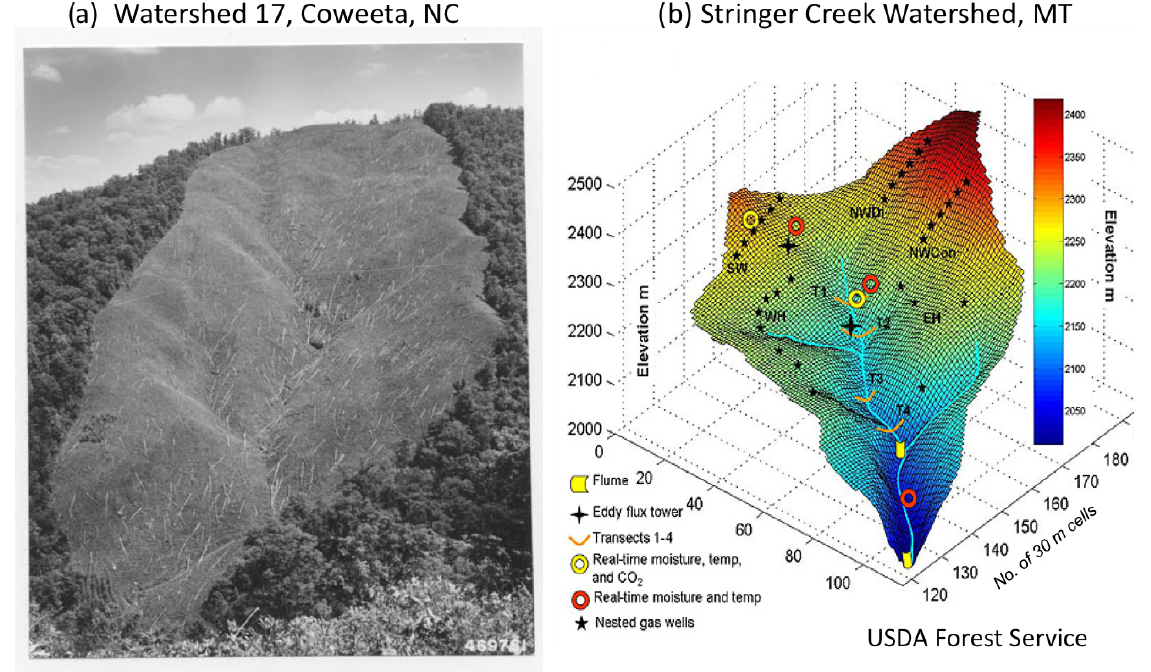
Figure 2. Throughout the 20th century, precipitation and streamflow were measured in watersheds, for example (a) at Coweeta Hydrologic Laboratory in western North Carolina, where in Watershed 17 catchment-hydrologic response to deforestation was quantified (Hursh et al., 1942). Watershed–ecosystem studies continue to quantify hydrologic responses to land uses but with greatly advanced instrumentation as in (b) the Stringer Creek watershed in Montana (available at: http://water.engr.psu.edu/gooseff/web_research/hydroscapes.html, last access: 2 August 2018). At Stringer Creek, within-watershed processes such as water storage, interflow, groundwater recharge, gas exchanges, nutrient flows, evapotranspiration, and other processes are estimated with advanced sensor technologies, often in real time, supported by lidar-generated digital elevation models and eddy covariance fluxes of energy, water, and